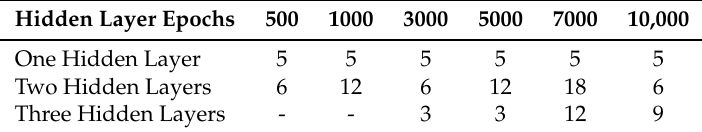
Table 3. Number of prepared ANN structures within the performance